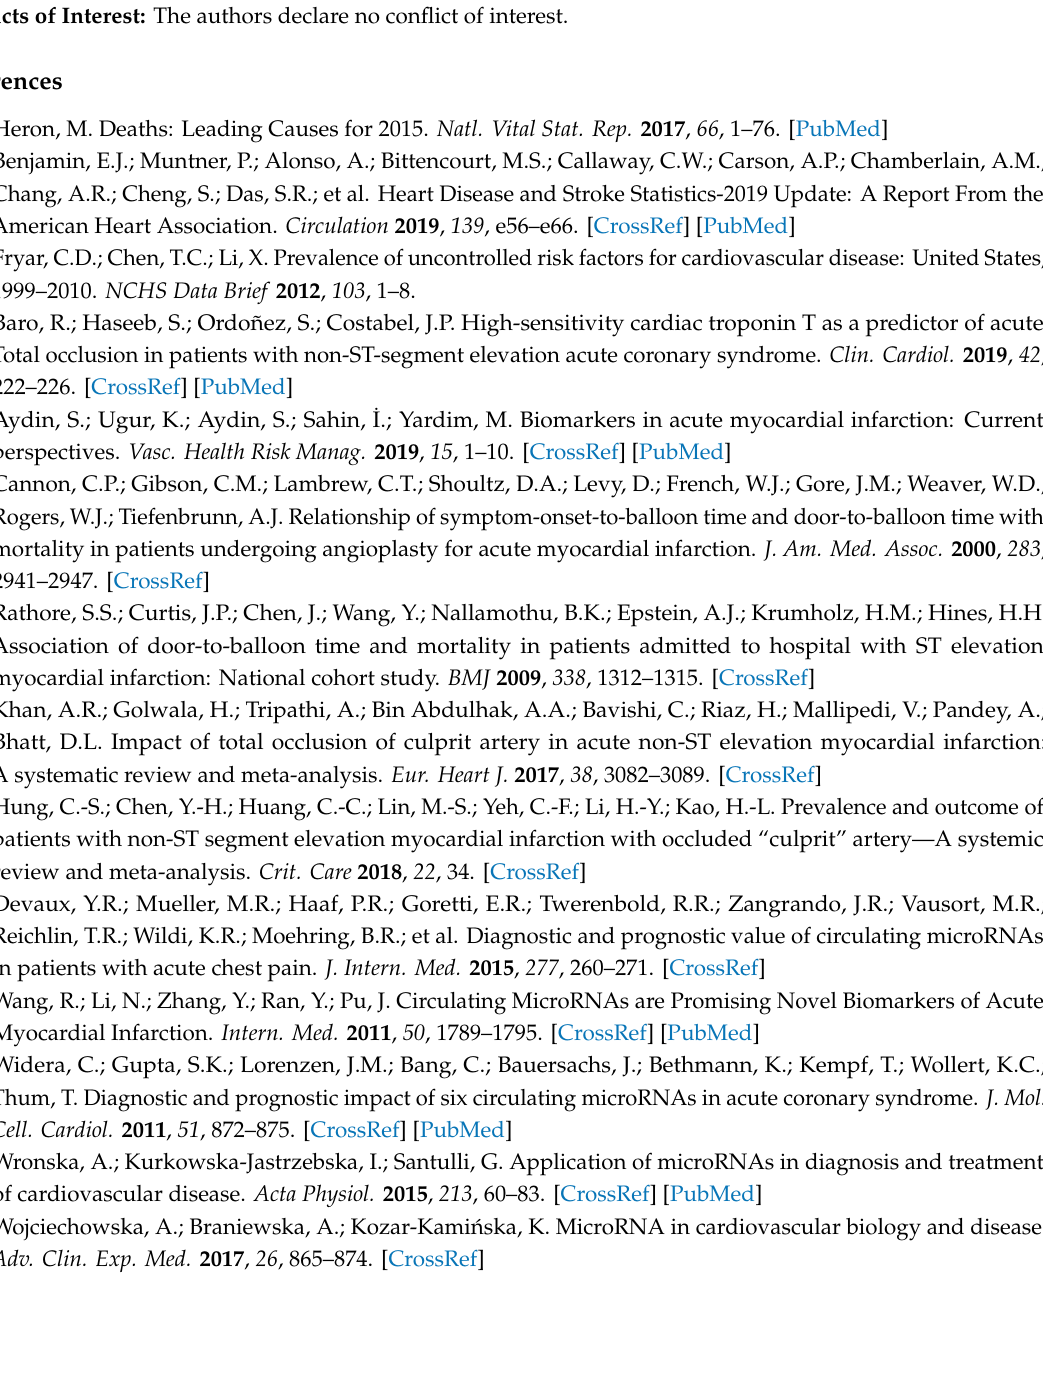
Figure S1: Trends as a function of %males, Figure S2: Trends as a function of age, Tables S1–S3: Complete Search Strategy. Table S4: PRISMA guidelines